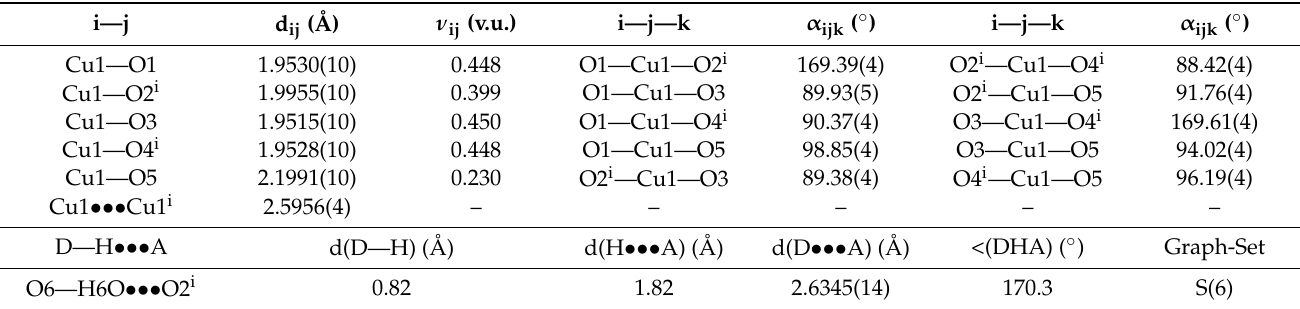
Table 2. Selected structural data of the studied